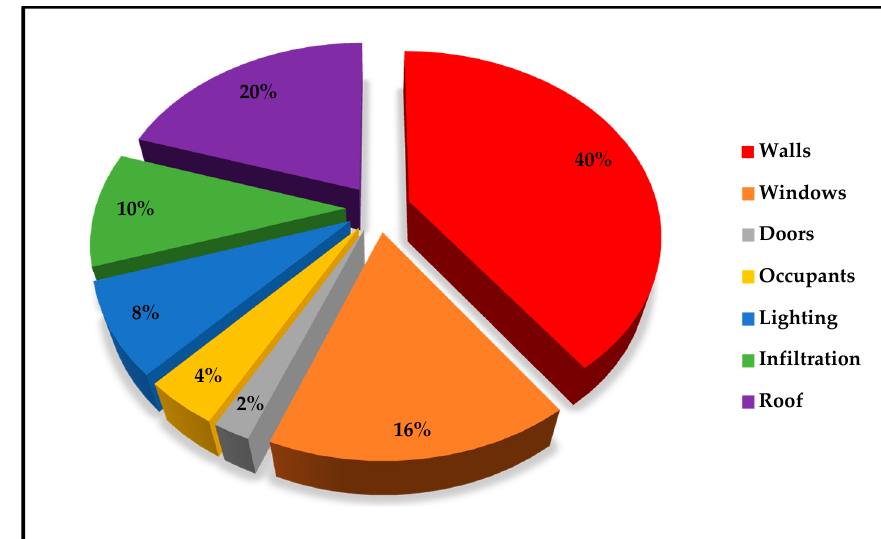
Figure 3. Design temperature profiles for August.